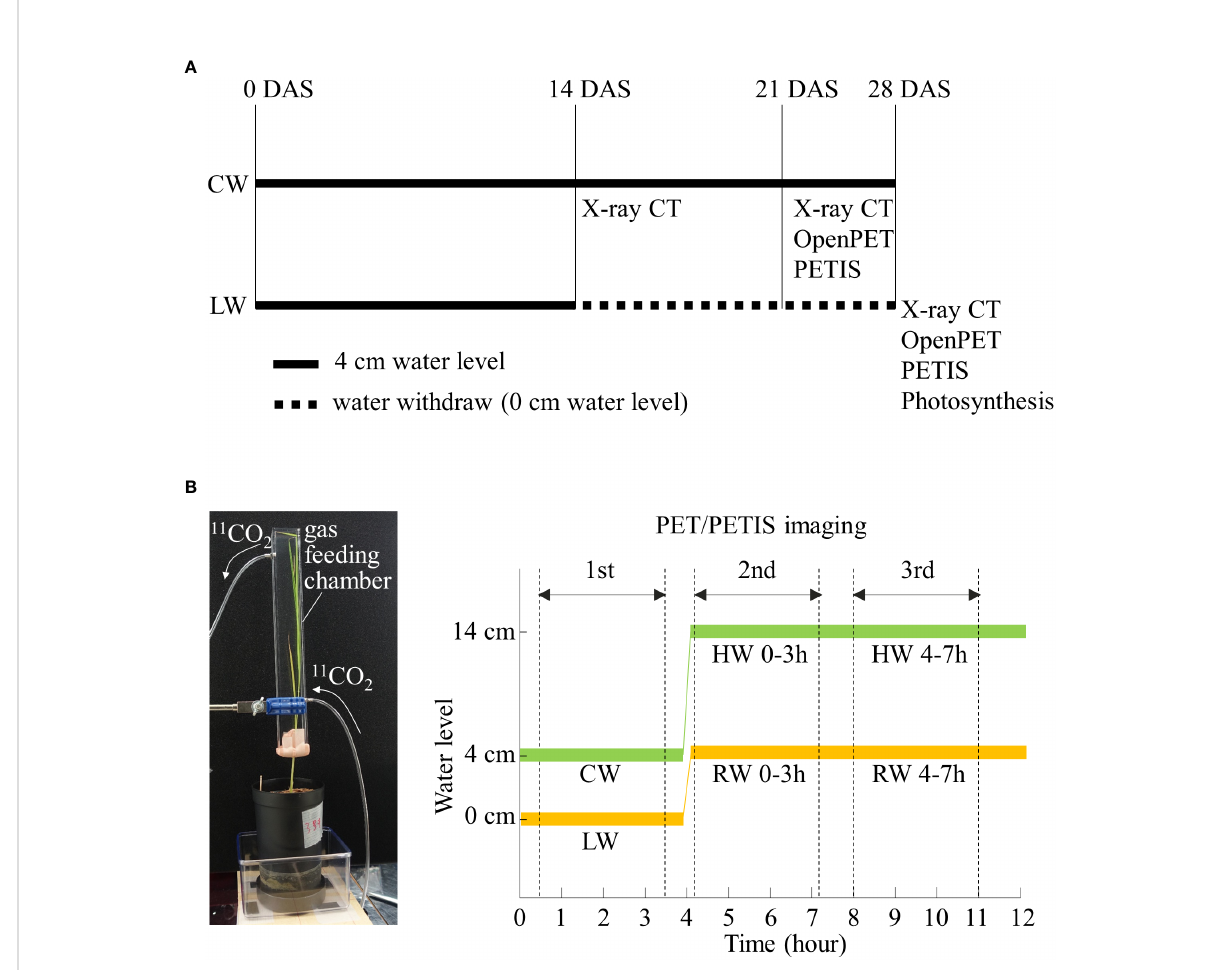
FIGURE 1 (A) Timing and duration of soil water conditions with rice plants grown under control water content (CW) and low water content (LW). The black thick line and black dotted line indicate the cultivation period with water level of 4 cm and 0 cm, respectively. The timing of X-ray CT, OpenPET/PETIS imaging and photosynthesis rate measurements are also shown. (B) Photograph of 11 CO 2 gas feeding chamber. Time course of water level during fi rst, second, and third OpenPET/PETIS imaging are also shown. RW and HW indicate “ recover water content ” and “ high water content ” , respectively. Zero min indicates the start of the lighting period in the growth